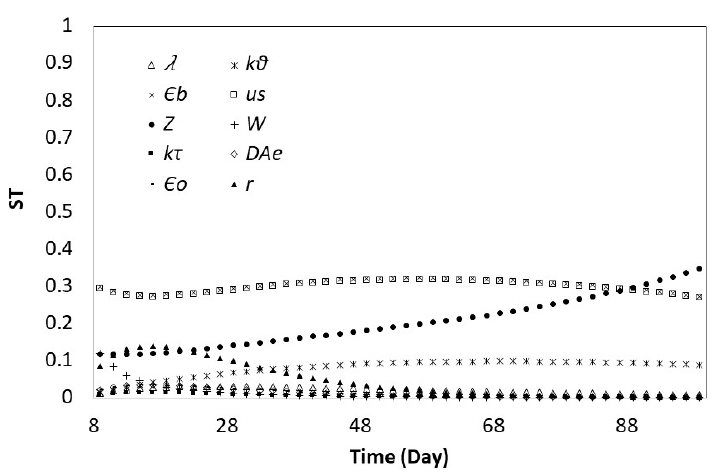
Figure 8. GSA of the model at radius 3.5 cm.